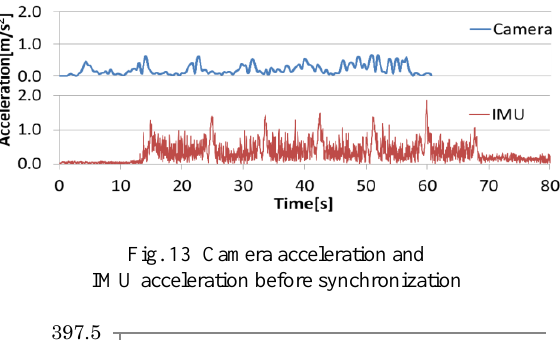
Fig. 13 Camera acceleration and